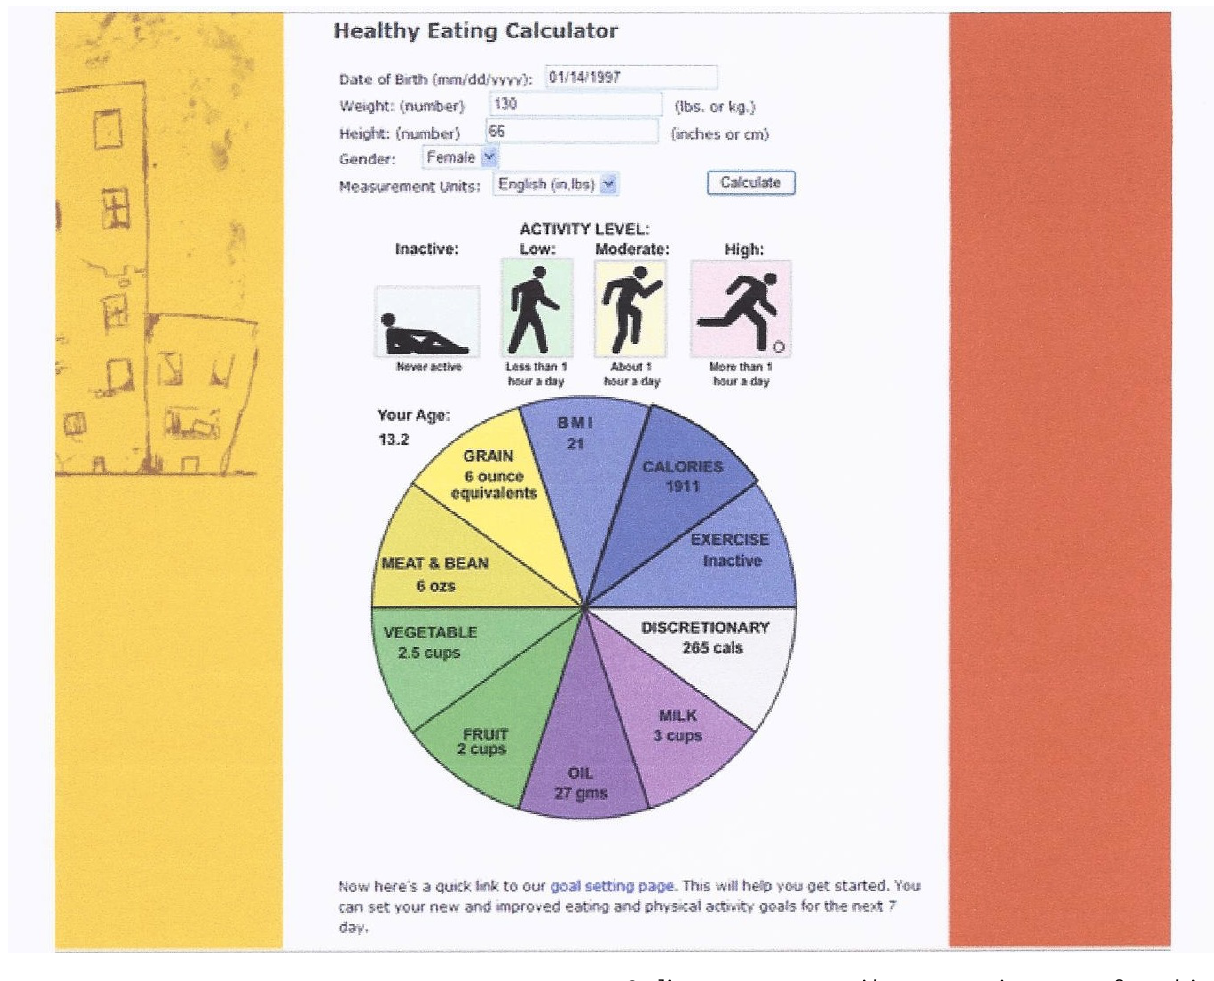
Figure 5. “Healthy Eating Calculator”